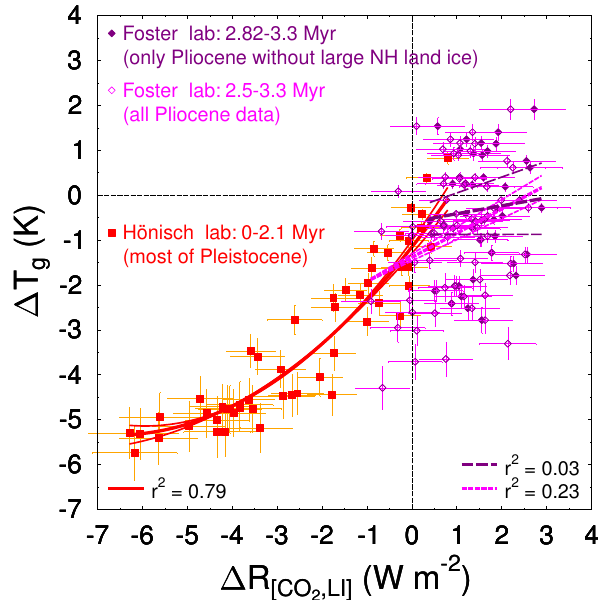
Figure 10. Best-guess 3 . 3Myr scatter plot of global temperature change, (cid:49)T g , against the radiative forcing of CO 2 and land ice albedo ( (cid:49)R [ CO ). The Hönisch lab (Hönisch et al., 2009) data 2 ,LI ] for the last 2 . 1Myr (most of the Pleistocene) and the Pliocene part of the Foster lab data (Martínez-Botí et al., 2015) – entire data (2.5– 3.3MyrBP) and only the data for the almost land-ice-free North- ern Hemisphere times (2.82–3.3MyrBP) – are compiled to illus- trate how the functional dependency between (cid:49)T g and (cid:49)R [ CO 2 ,LI ] changed as function of background climate